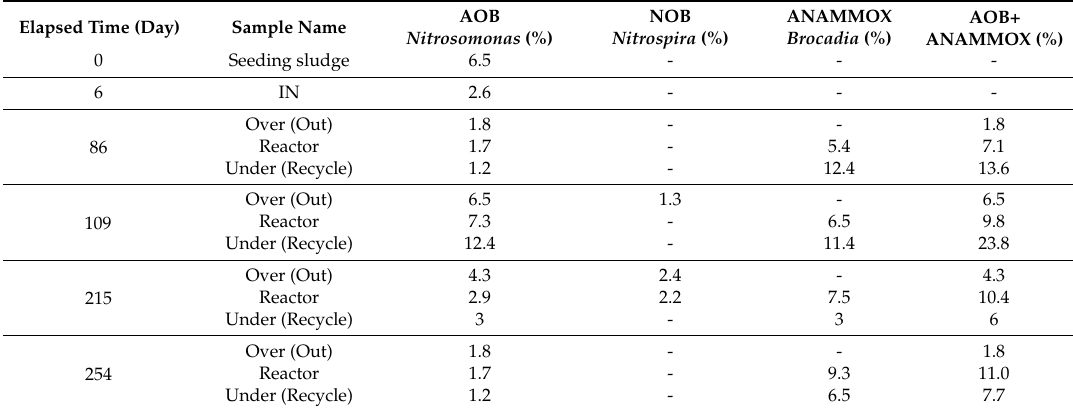
Table 2. Changes in the microbial community at the genus